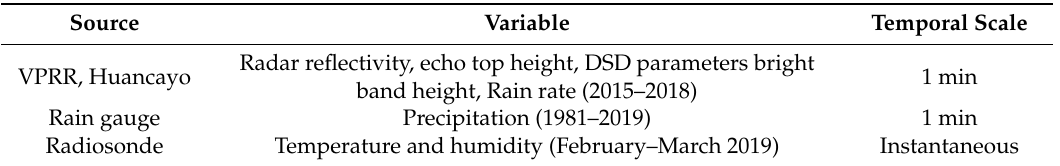
Table 2. Summary of the data sources used in the present